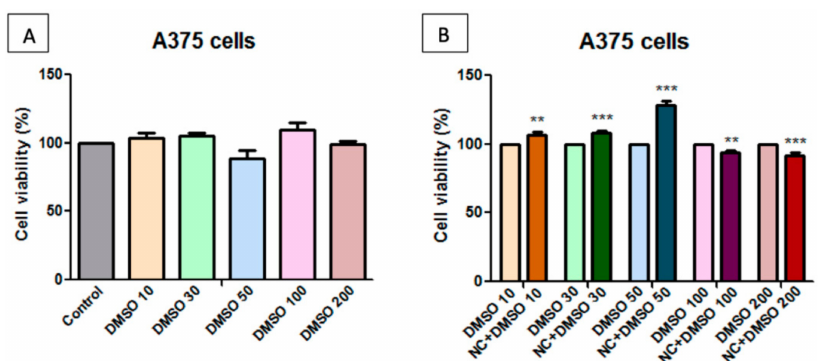
Figure 10. A —E ff ect of DMSO concentrations on human melanoma—A375 cell viability at 24 h